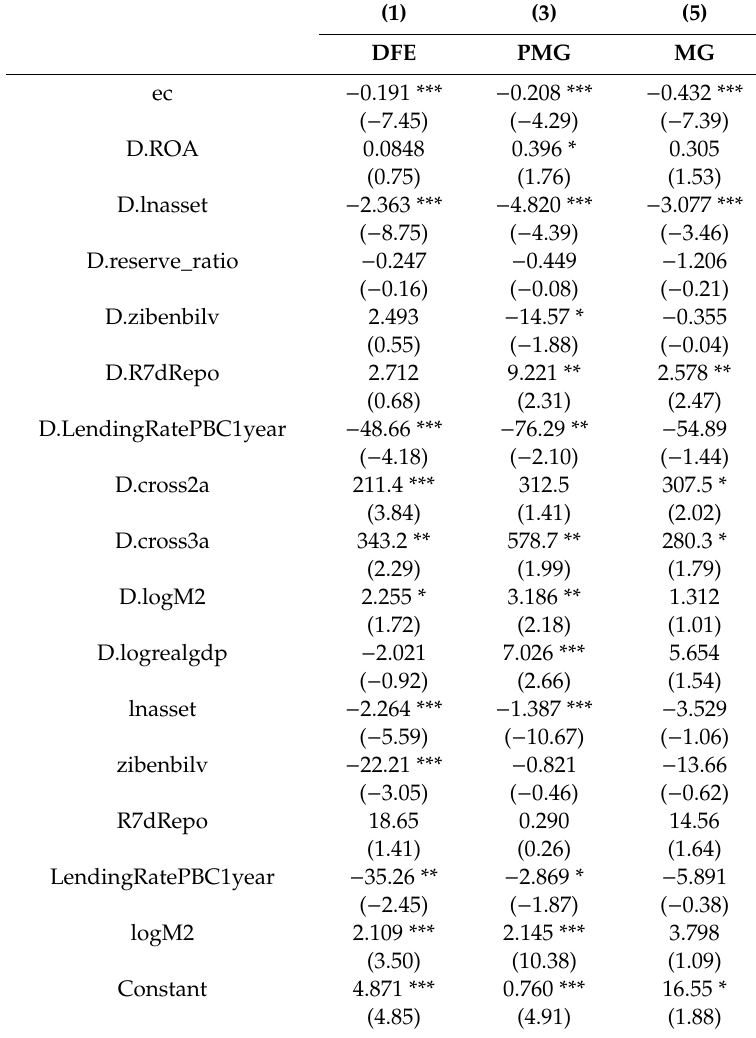
Table 7. Results of the regression analysis of Model